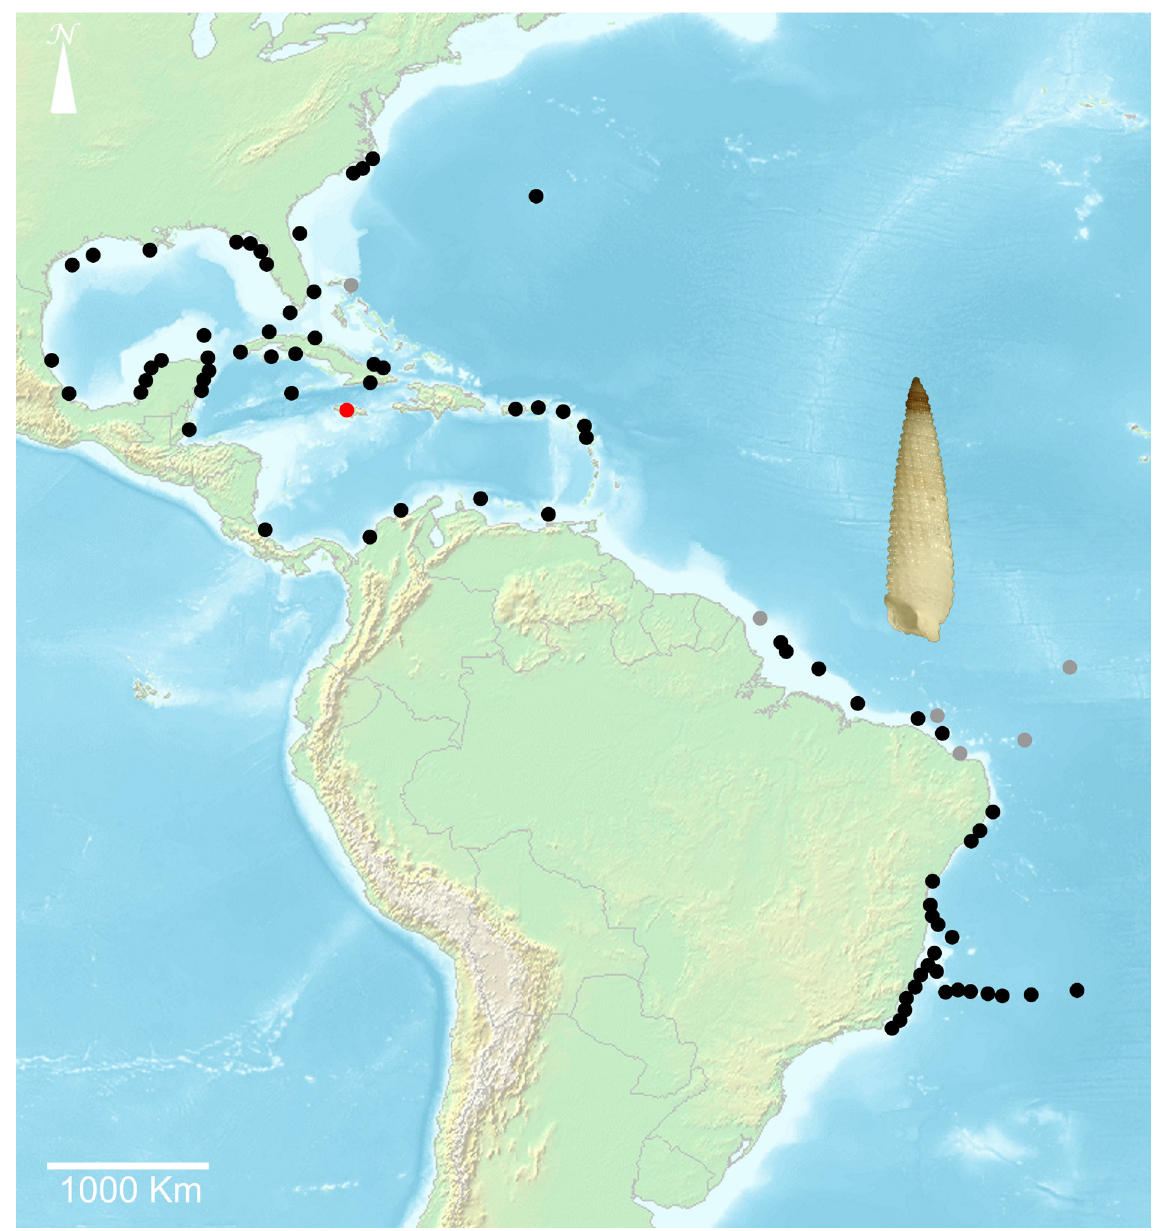
Fig. 32. Distribution map of Cosmotriphora melanura (C.B. Adams, 1850) (red circle = type locality), with gray circles representing the sympatry of C . melanura with atypical shells ( Cosmotriphora cf. melanura